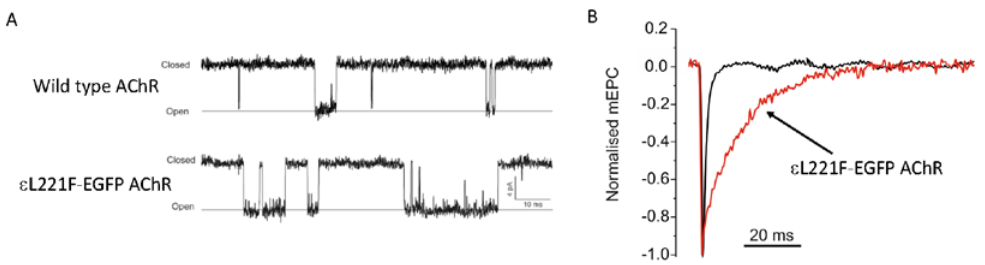
Figure 3. Panel ( A ) shows single channel recordings from HEK 293 cells transfected with either wild type AChR subunits or wild type AChR subunits plus εL221F -EGFP mutant AChR subunit. Prolonged bursts of openings are evident (downward deflections) stimulated by low concentration of ACh (100 nM). Panel ( B ) shows mEPC recordings from diaphragm muscle of mutant mice expressing εL221F -EGFP containing AChR (red trace). Endplate currents are prolonged in these mice as a result of the increased duration of AChR burst